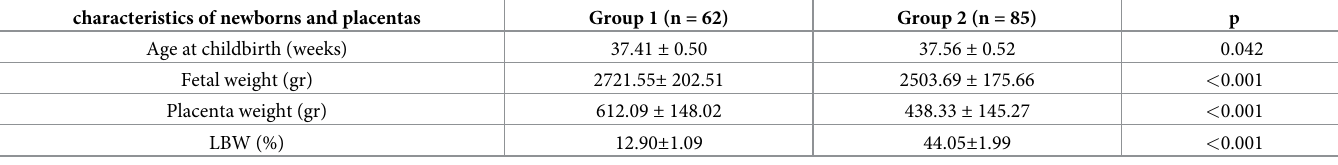
Table 2. Characteristics of newborns and placentas. characteristics of newborns and placentas